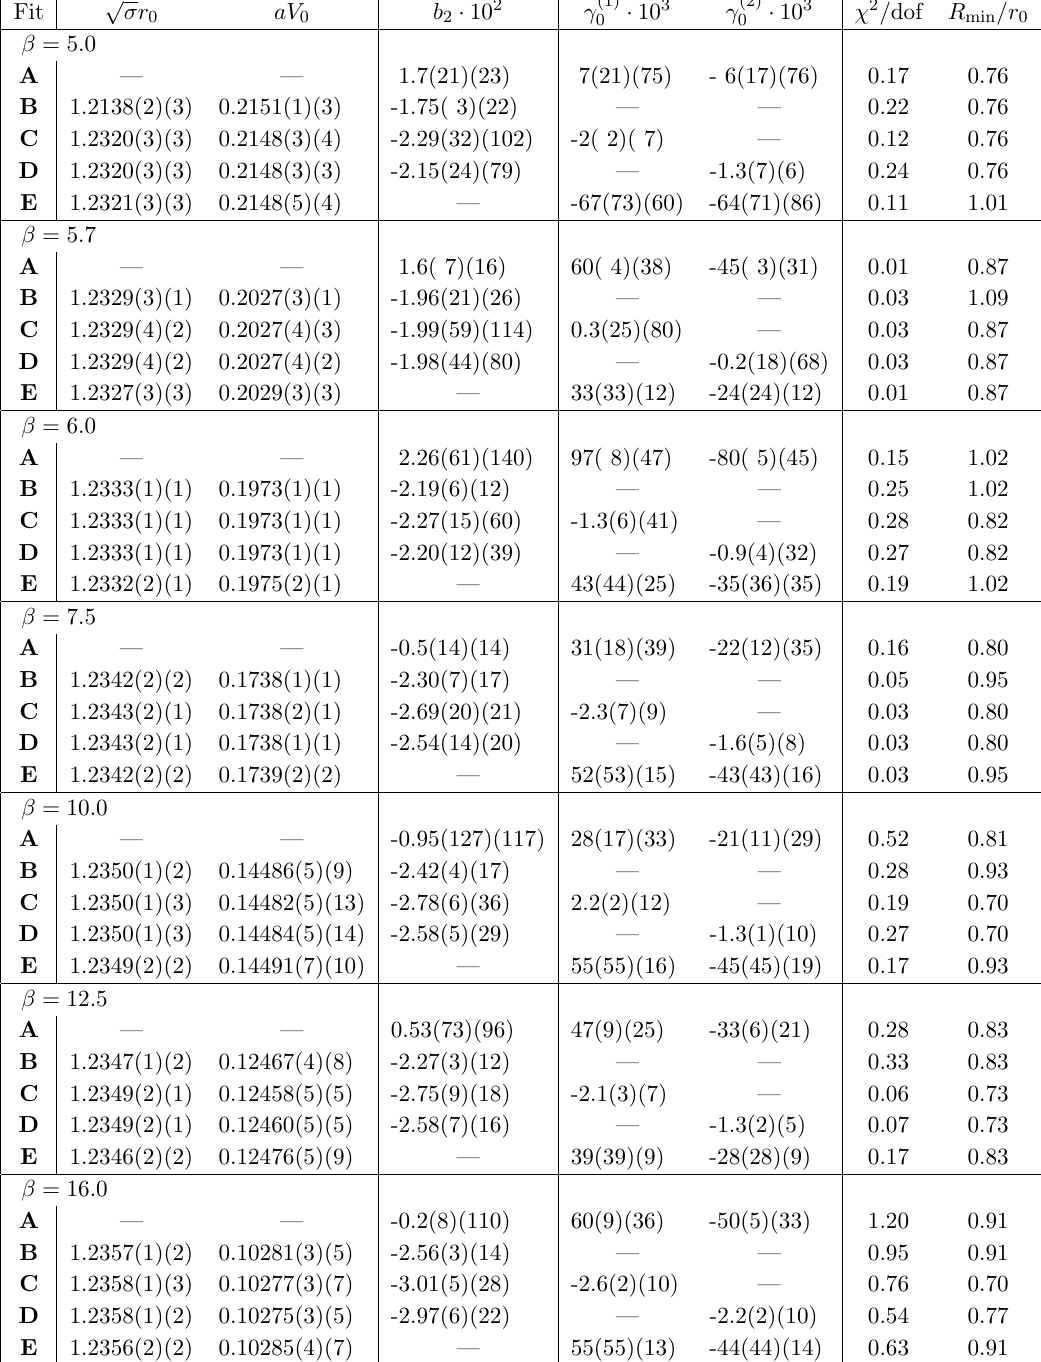
Table 5 . Results of the (cid:12)ts for the extraction of (cid:22) b 2 for SU(2) gauge theory.